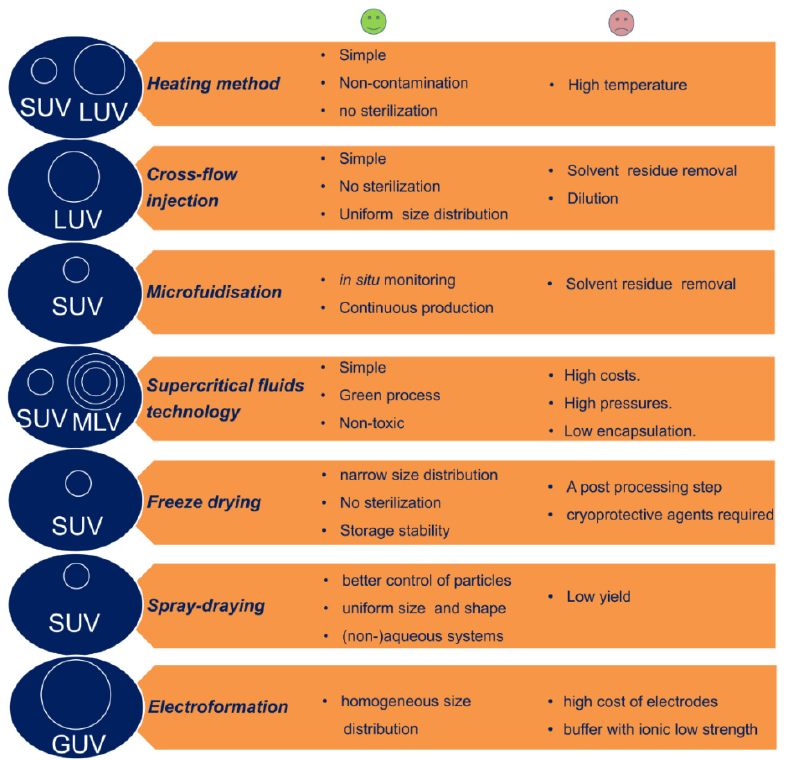
Figure 9. Main methods for large-scale production of liposomes.